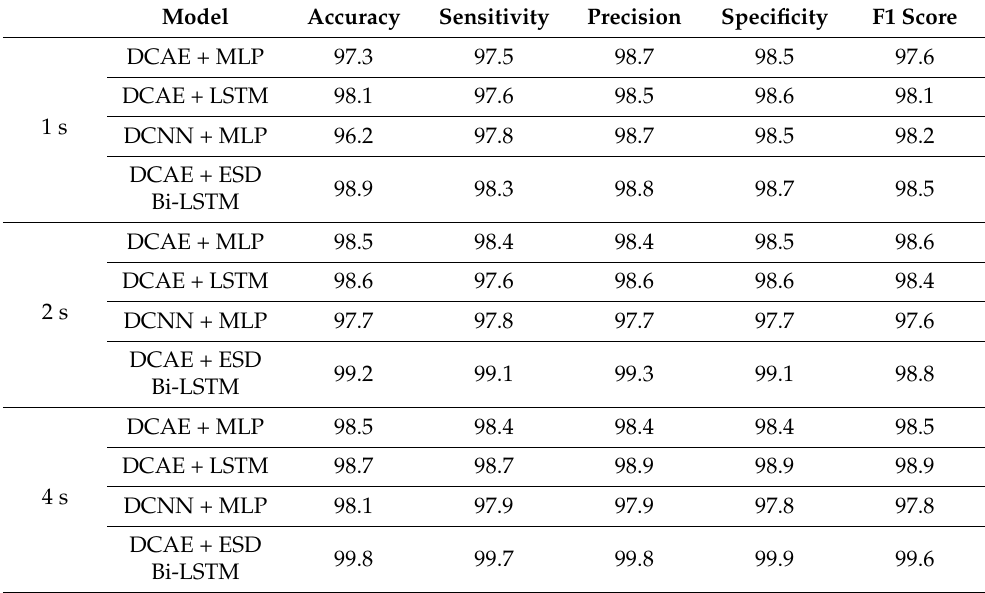
Table 2. Performance metrics of different models with different EEG segment lengths.